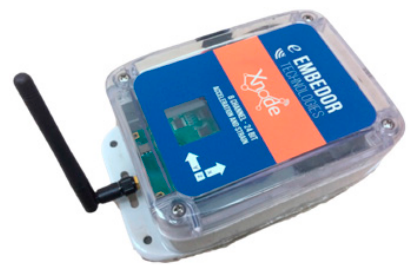
Figure 2. Enclosed Xnode smart sensor.